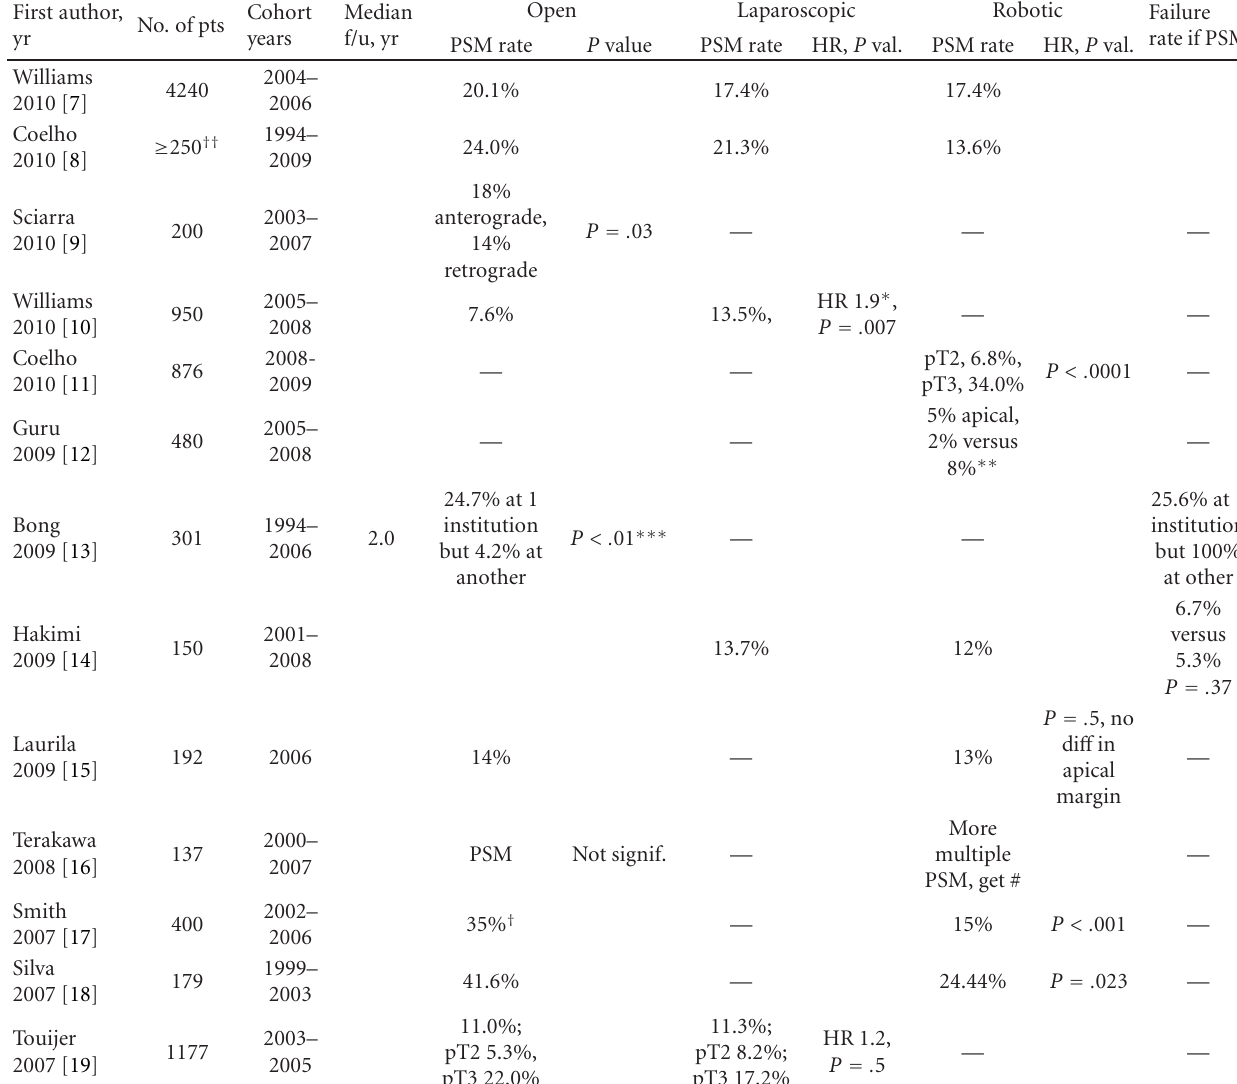
Table 1: Comparison of PSM rates by technical